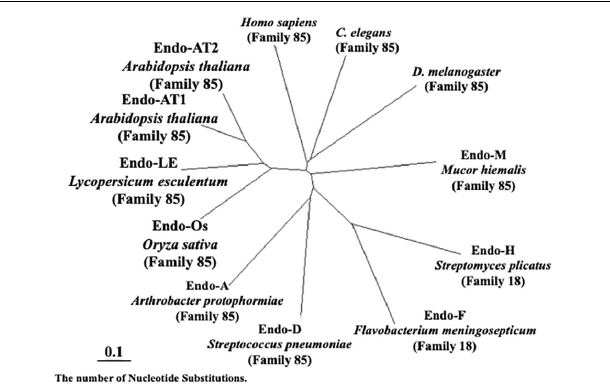
FIGURE 7 | Neighbor-joining phylogenetic tree of amino acid sequences of Endo- β -GlcNAc-ase. Amino acid sequences of Oryza sativa (Endo-Os, Q5W6R1) used the putative endo- β -GlcNAc-ase sequence. Arabidopsis thaliana-1 (Endo-AT1, F4JZC2), A. thaliana-2 (Endo-AT2, Q9SRL4), Lycopersicum esculentum (Endo-LE, A0A3Q7HNF7), Homo sapiens (Q8NFI3), C. elegans (Q8TA65), D. melanogaster (Q9VX51), Mucor hiemalis (Endo-M, Q9C1S6), Streptomyces plicatus (Endo-H, Q93HW0), Flavobacterium meningosepticum (Endo-F, P36911), Streptococcus pneumoniae (Endo-D, Q93HW0), and Arthrobacter protophormiae (Endo-A, Q9ZB22).